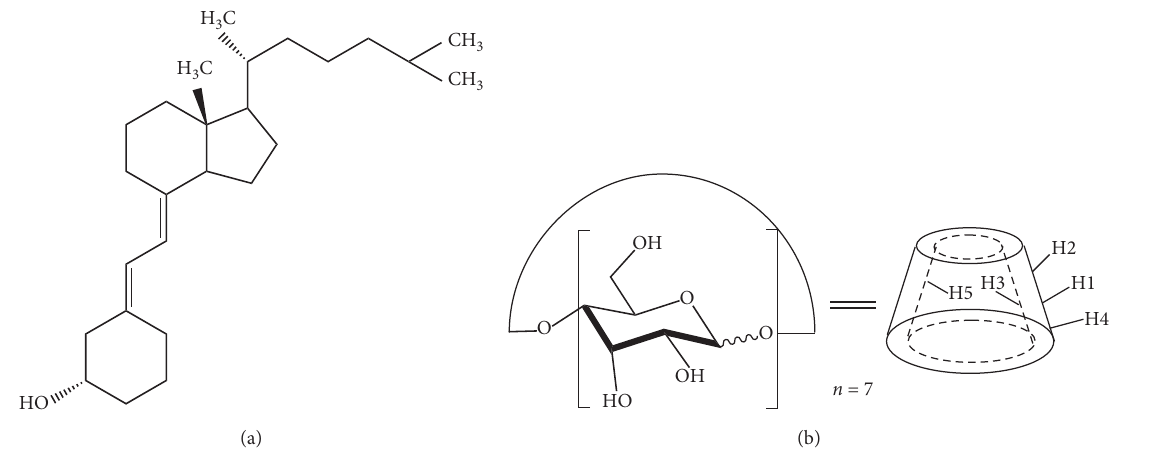
Figure 1: Structural formulas of cholecalciferol (a) and β -cyclodextrin